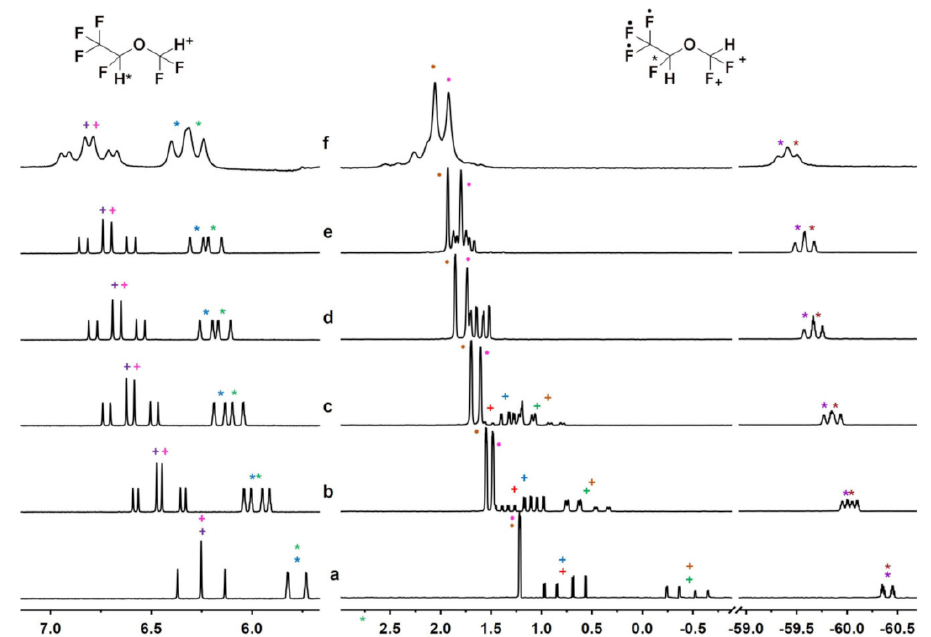
Figure 3. 1 H (600 MHz, 25 ◦ C, C 6 D 12 ) ( left ) and 19 F (564 MHz, 25 ◦ C, C 6 D 12 ) ( right ) NMR spectra of DSF (30 mM) alone ( a ) and in the presence of AcSi γ CD to give a DSF/CD molar ratio of 8:1 ( b ), 4:1 ( c ), 3:1 ( d ), 2:1 ( e ) and 1:1 ( f ). The different colors help in visualizing the splitting of the signals